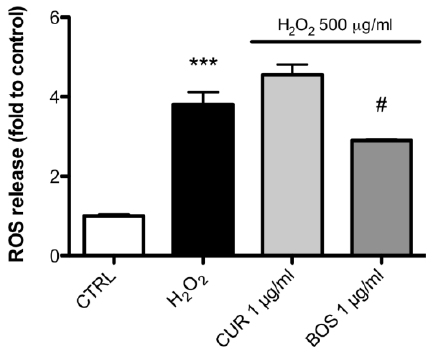
Figure 6. ROS release in Caco-2 cells after H 2 O 2 stimulation (500 µg/mL); cells were preincubated with CUR and BOS for 24 h. *** p < 0.001 vs. control; # p < 0.05 vs. stimulus.